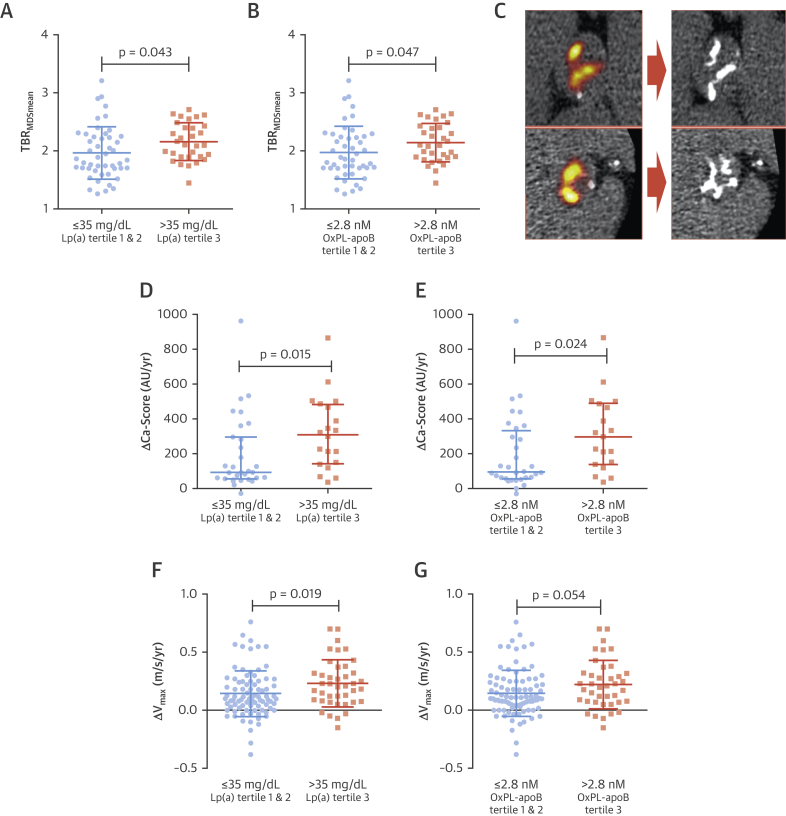
Baseline Calcification Activity and Aortic Stenosis Progression According to Patient Lp(a) and OxPL-apoB LevelsAt baseline, patients in the top Lp(a) and OxPL-apoB tertiles have increased valvular 18F-NaF uptake, as a marker of calcification activity, compared with the combined middle and bottom tertiles (A and B). (C) Two examples of increased valvular 18F-NaF PET uptake at baseline (left), which predicted progression to macrocalcification on CT after 2 years (right)(16). Patients in the top Lp(a) and OxPL-apoB tertiles also demonstrated faster progression in aortic valve CT calcium score (D and E), and faster hemodynamic progression, expressed as the annualized change in peak aortic jet velocity (ΔVmax) (F and G). Abbreviations as in Figure 1.